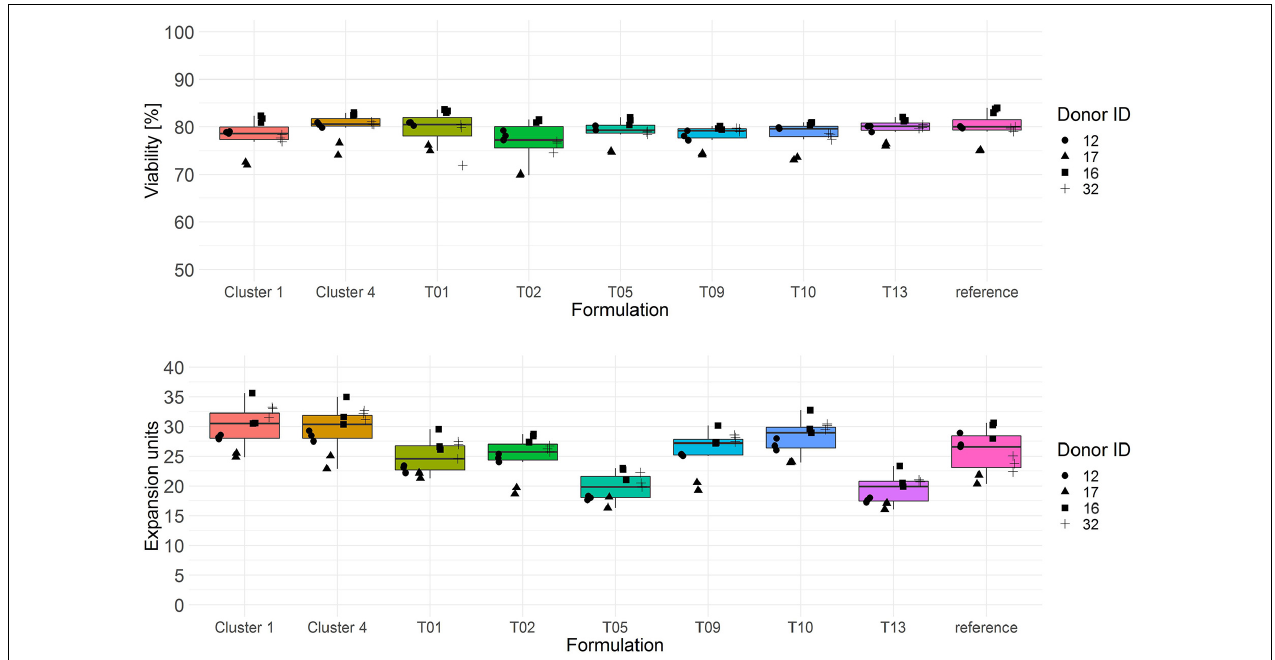
FIGURE 6 | Cryopreserved CD3 + T cells purified from human donors ( n = 4) were thawed and activated using anti-CD3/anti-CD28-coupled magnetic beads in test media or reference media in the presence of IL-7 and IL-15 (10 ng/ml, CellGenix) in three technical replicates. On day 3 cells were labeled with 7-AAD and cell viability was determined (upper panel) . On day 6 cell counts were determined by flow cytometry. T cell expansion is expressed in expansion units (lower panel) . Symbols indicate replicate values of individual donors.